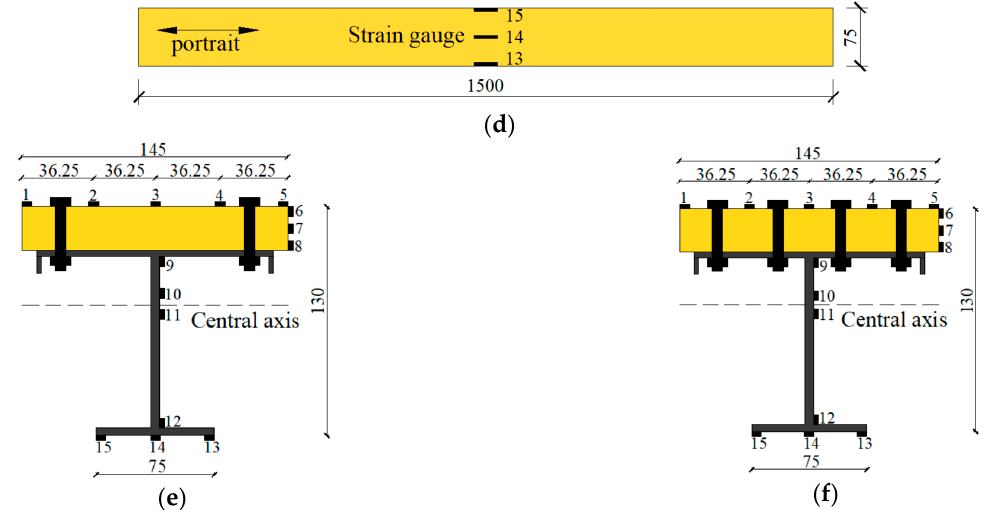
Figure 3. Arrangement of instrument and strain gauge (unit: mm): ( a ) Loading device arrangement; ( b ) Arrangement of loading device, displacement gauge and dial gauge; ( c ) Arrangement of strain gauges on the timber surface; ( d ) Arrangement of strain gauges on the lower surface of I-beam bottom; ( e ) Midspan section of the L1 test specimen; ( f ) Midspan section of L2–L4 test specimens.